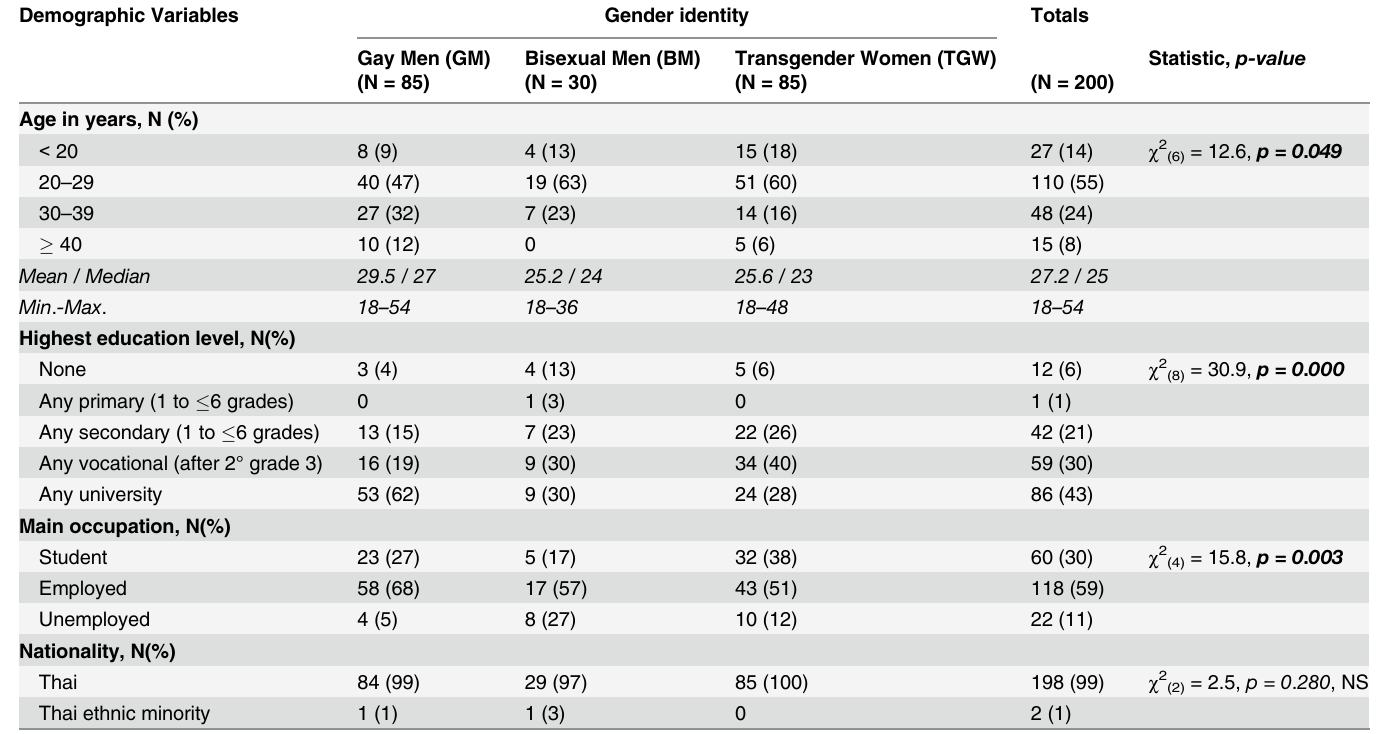
Table 1. Demographic characteristics of age, education, occupation, and nationality, by gender-identity of MSM subjects in Chiang Mai, Thailand, 2012 – 2013. Demographic Variables Gender identity Totals Gay Men (GM) Bisexual Men (BM) Transgender Women (TGW) Statistic,